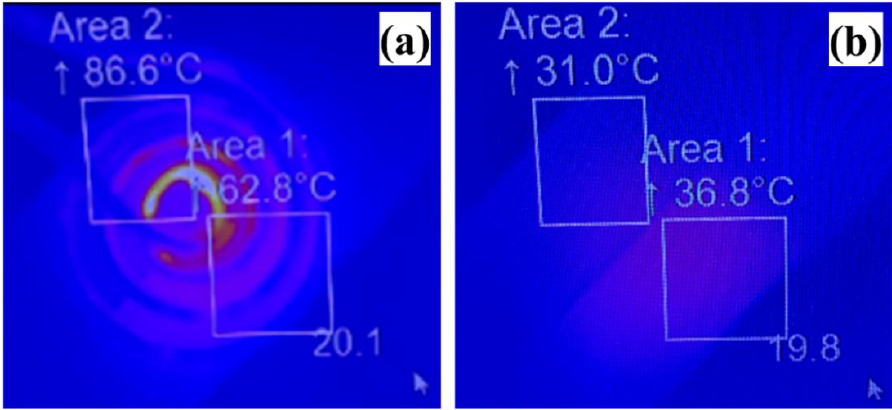
Figure 10. Exposing the dry layer samples (Fe 3 O 4 20 nm doped in poly-NIPA photopolymer) to AMF; the obtained results are shown in ( a ) during exposure and ( b ) after exposure to AMF.